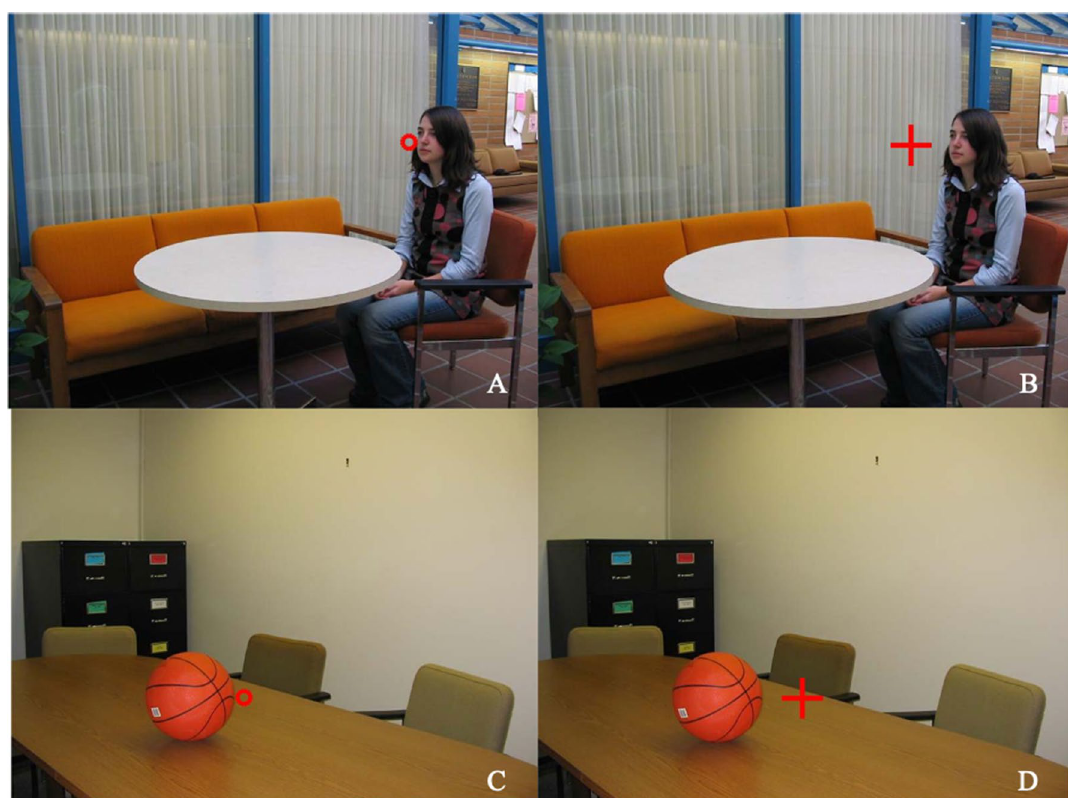
Figure 1. Experimental stimuli. The left panels provide an example of a small circle cursor whose centre is displaced 15 pixels (Distance 2) from the nearest edge of a person [( A ) animate scene] or object [( C ) inanimate scene]. The right panels provide an example of a large cross cursor displaced at a maximum distance of 60 pixels (Distance 5) for a person [( B ) animate scene] or object [( D inanimate